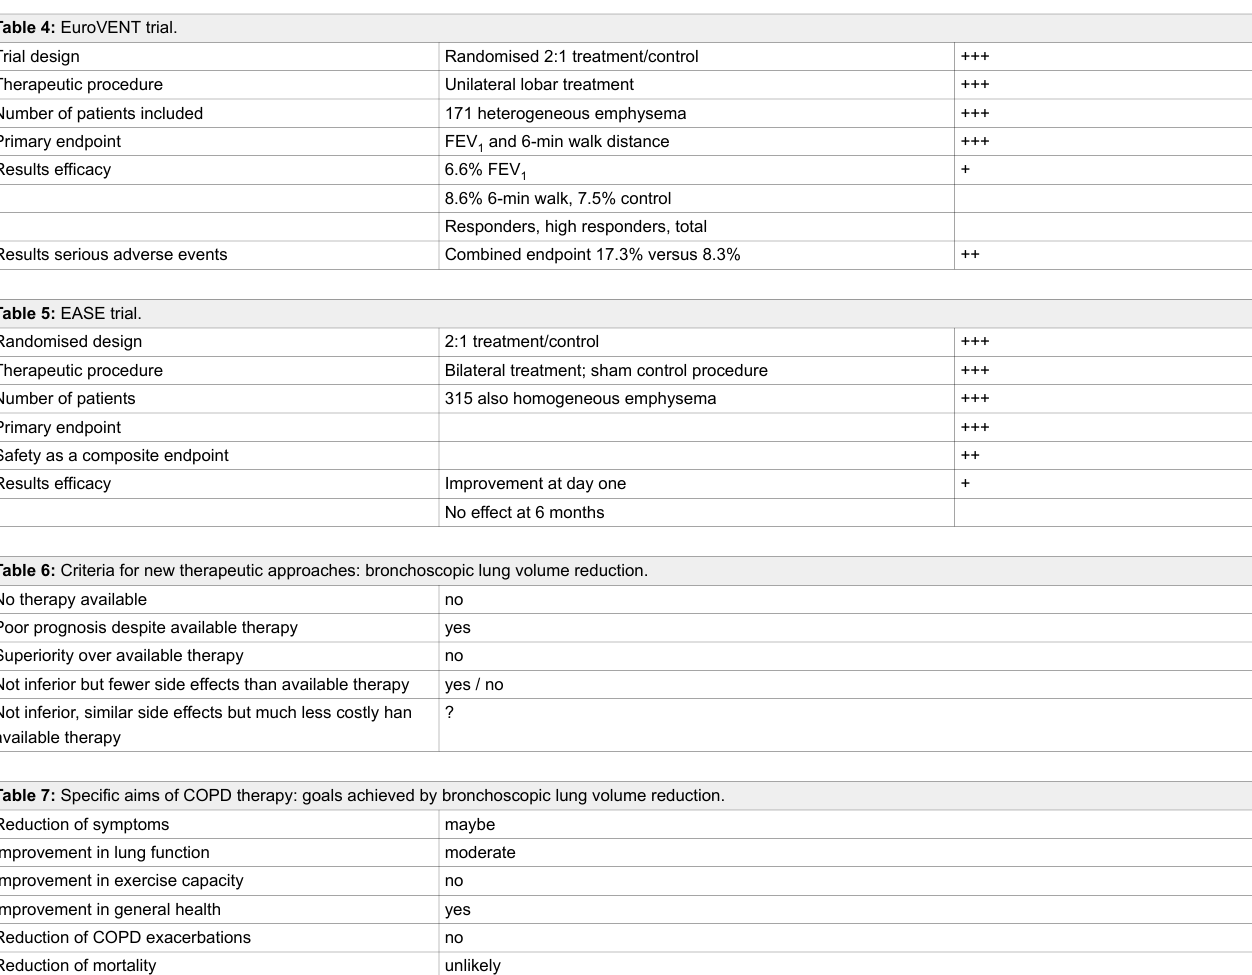
Table 4: EuroVENT trial. Trial design Randomised 2:1 treatment/control +++ Therapeutic procedure Unilateral lobar treatment +++